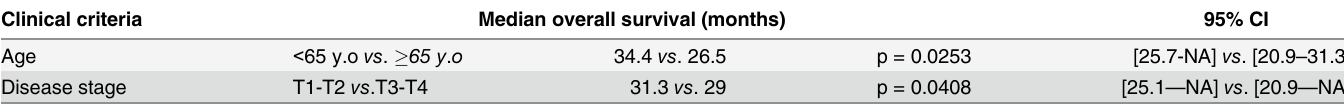
Table 4. Median overall survival according to different criteria.